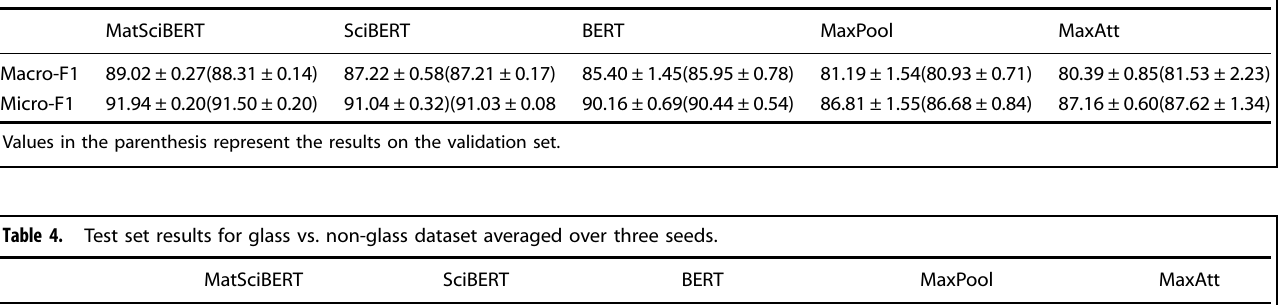
Table 3. Test set results for Materials Synthesis Procedures dataset averaged over three seeds.